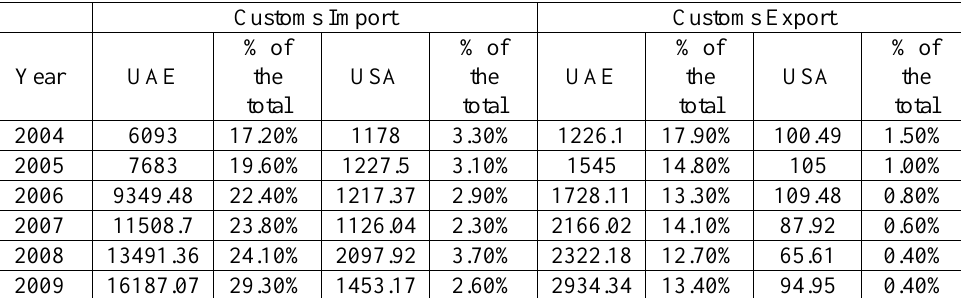
Table 5-4. Foreign Trade between 2004 and 2009 (USD million) Customs Import Customs